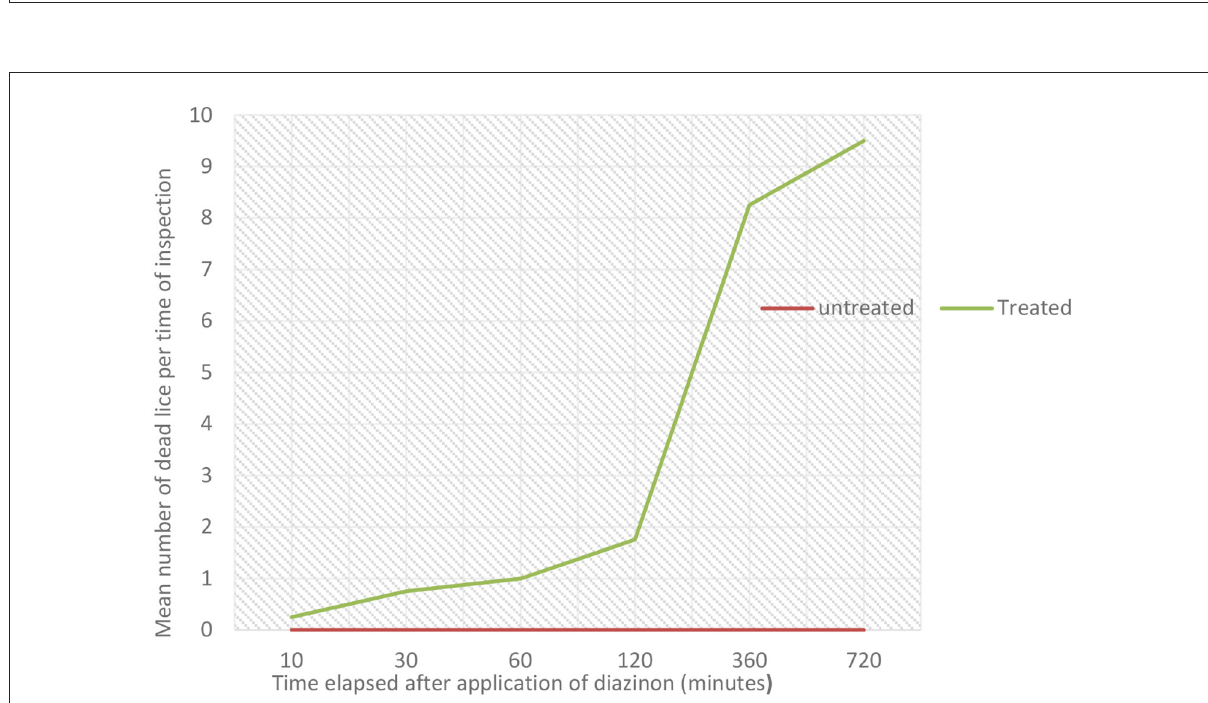
FIGURE5 Effect of in-vitro diazinon treatment on the mean number of dead lice per time of